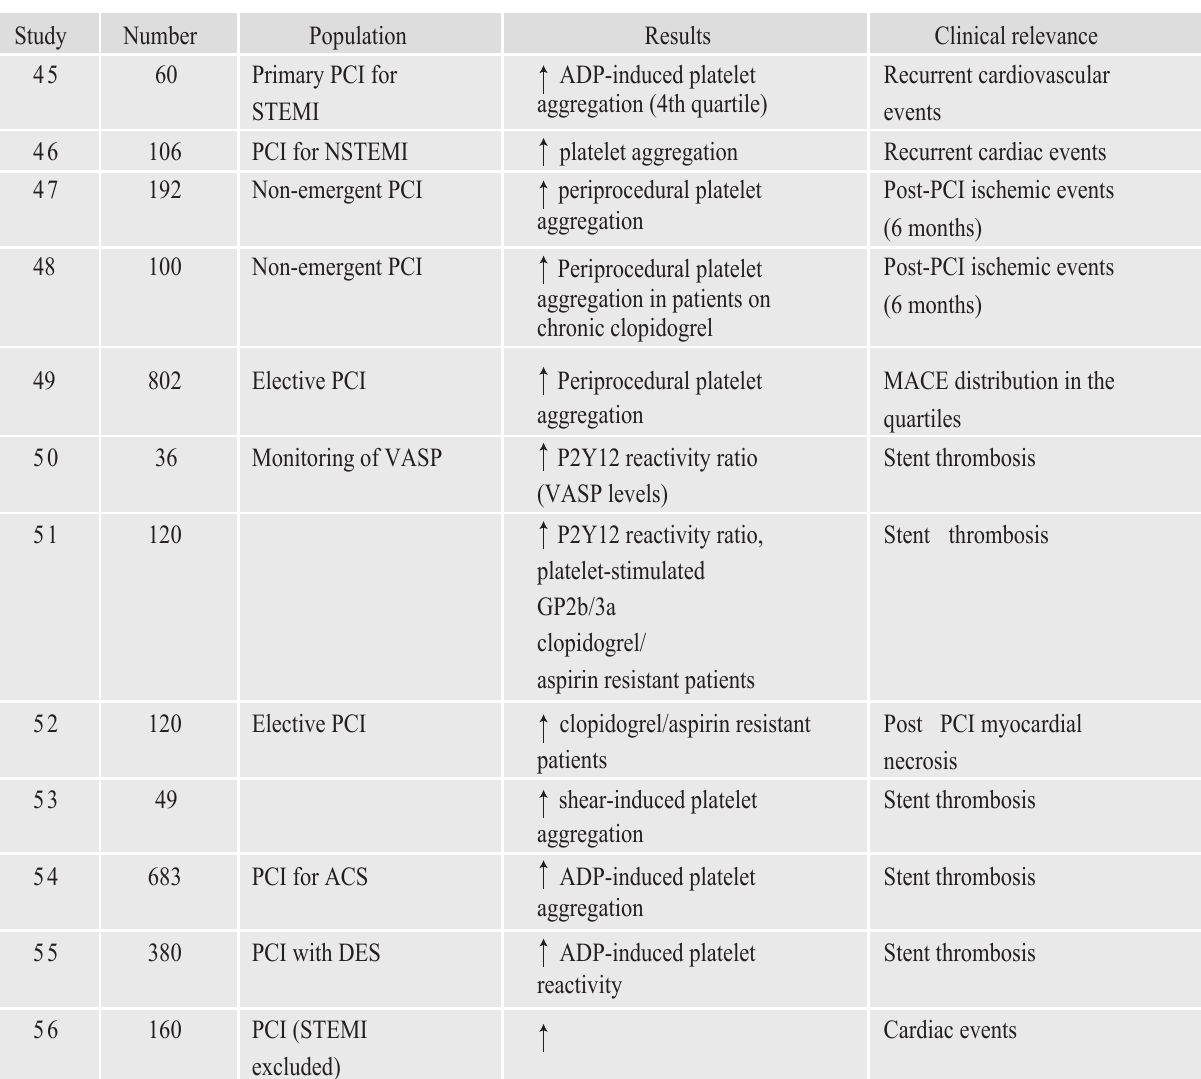
Table I: Overview of studies analyzing clinical outcomes of clopidogrel resistance(cid:13)